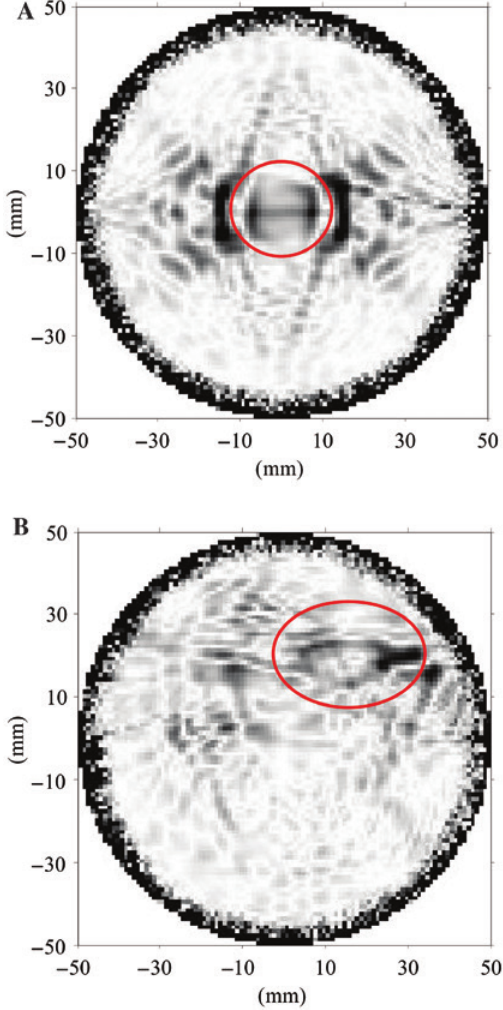
Figure 7: Tomographic images of flawed models reconstructed using the revised TOF data: (A) a flawed model with a hole in the center and (B) a flawed model with a hole in coordinates (15,20).